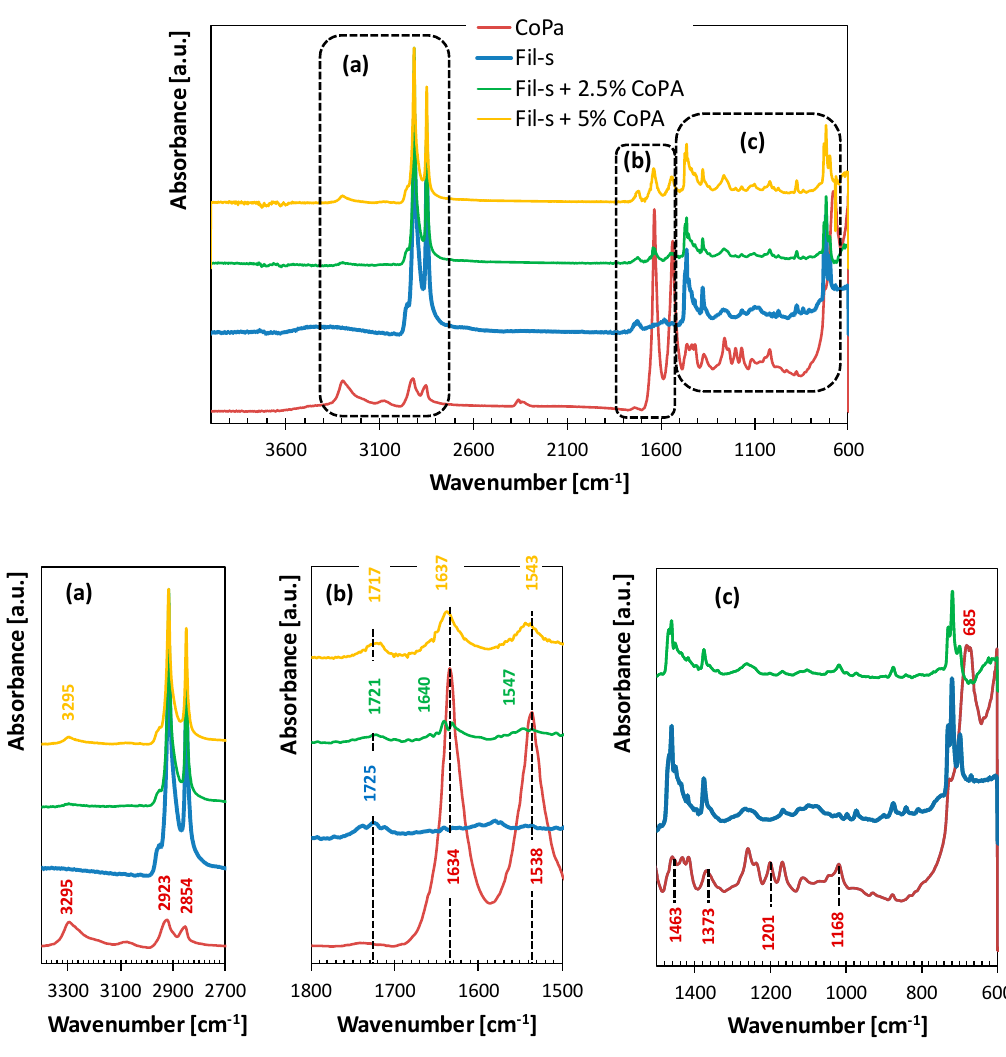
/ ATR spectra of Fil-s, the neat copolyamide, and their Figure 1. Comparison of FTIR/ATR spectra of Fil-s, the neat copolyamide, and their blends. Figure 1. Comparison of FTIR